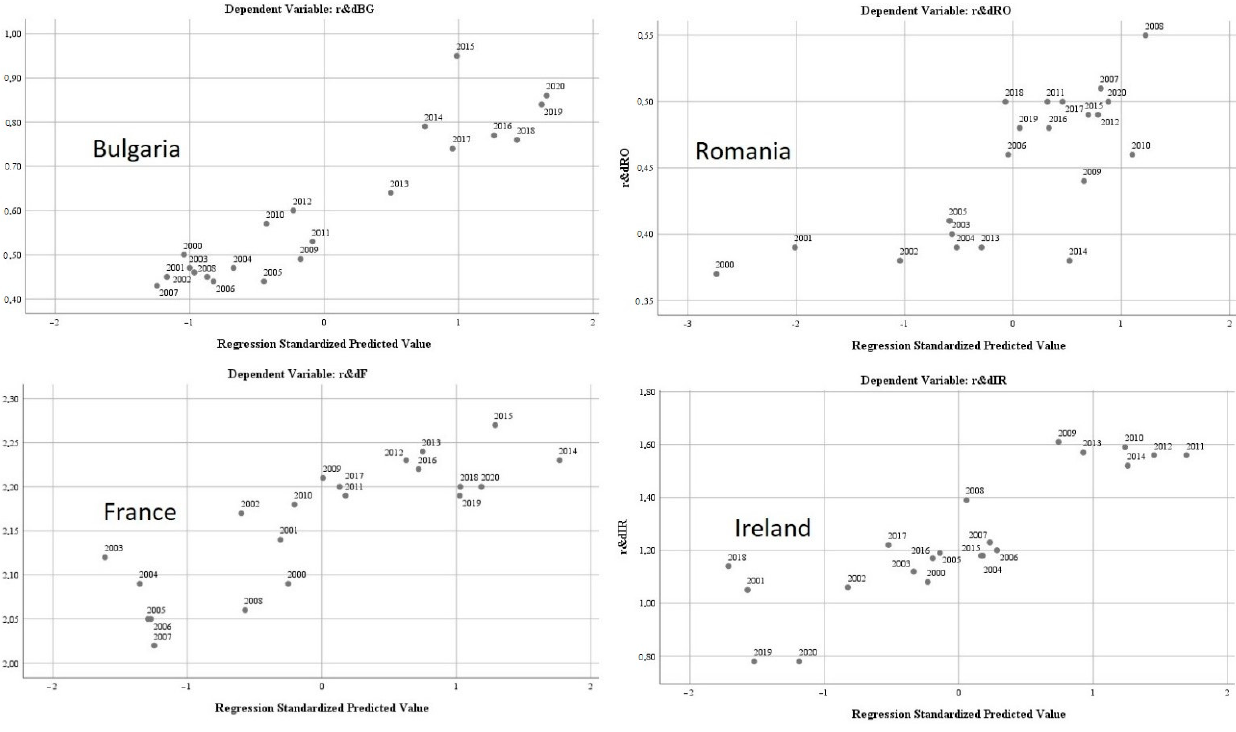
Figure 10. Regression analysis on analysed four countries vs the average EU situation during 2000–2020. Source: Data operated under IBM-SPSS 25 (IBM, Armonk, NY, USA).